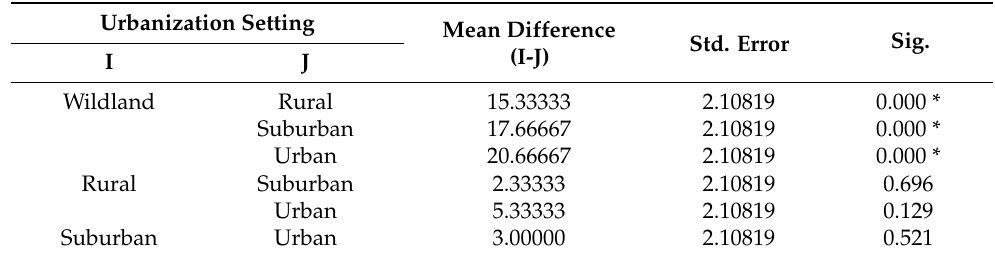
Table 3. Multiple comparisons on the number of native species in urban, suburban, rural, and wildland areas in Ipoh, Perak,